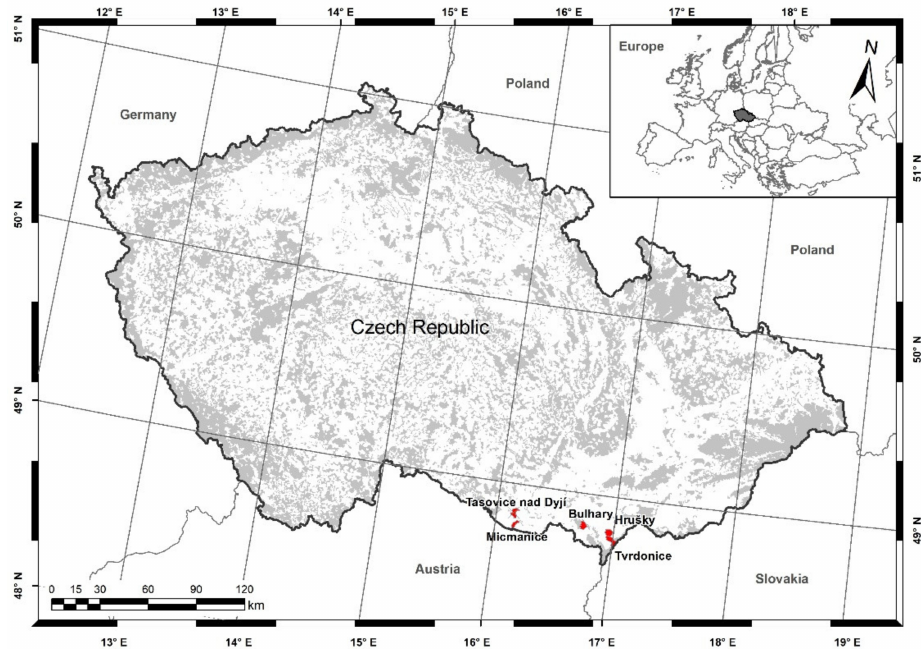
Figure 3. Location of five study localities of the Czech Republic (grey colour indicates forest cover).